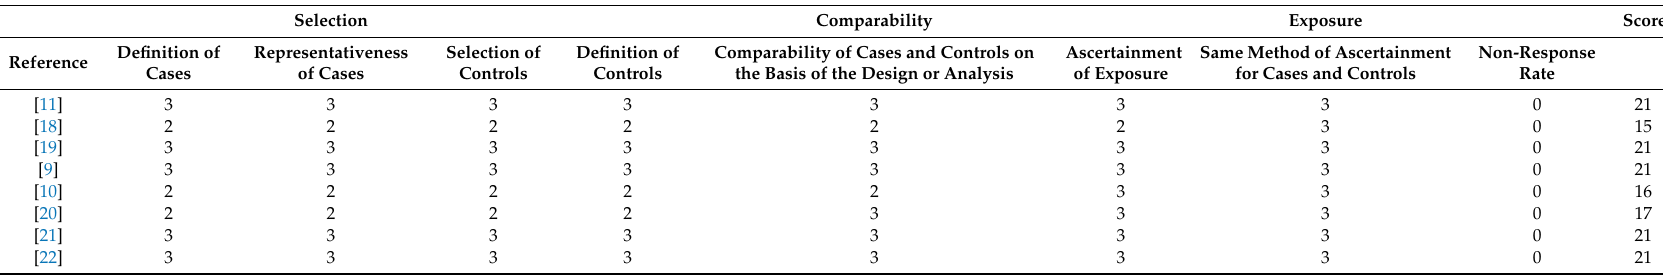
Table 6. Assessment of risk of bias within the studies (Newcastle–Ottawa scale) with scores 7–12 = low quality, 13–20 = intermediate quality, and 21–24 = high